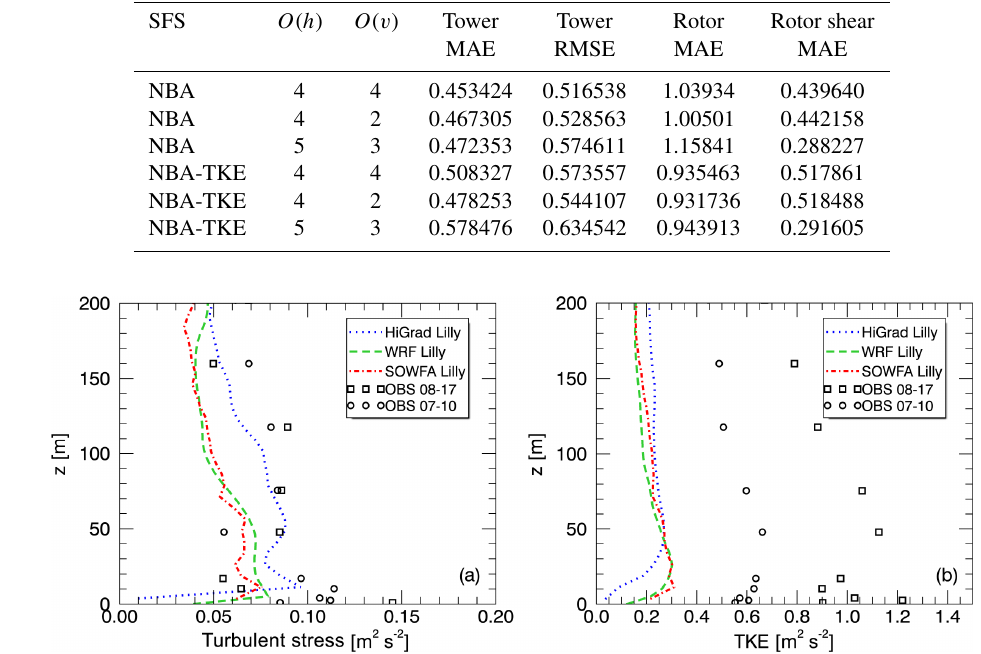
Table 5. Analysis of WRF LES performance using different advection schemes with the NBA and NBA-TKE SFS parameterization.